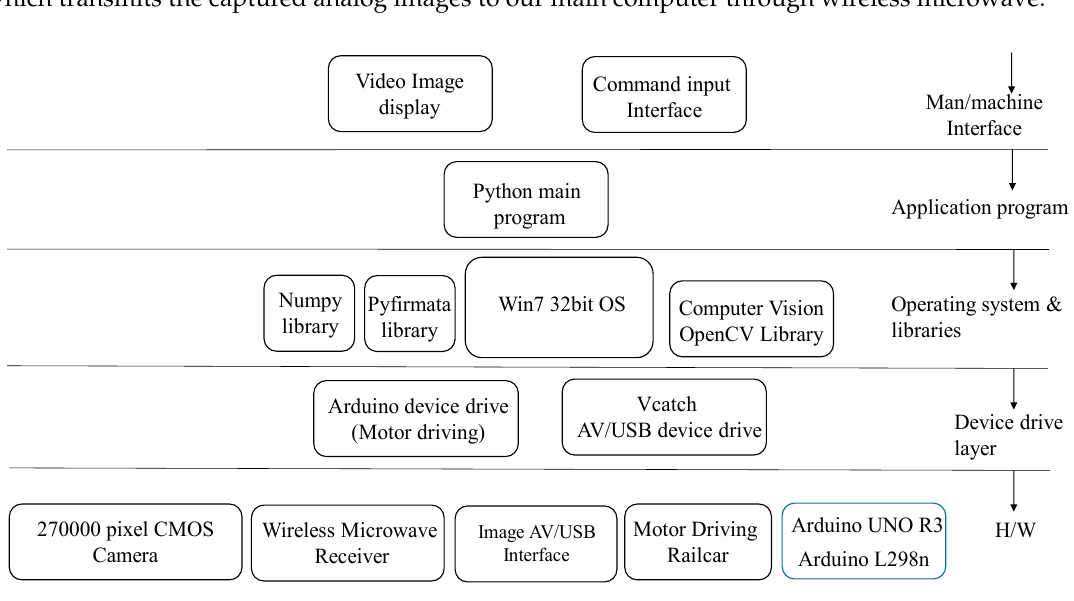
Figure 6. The experiment facility. 4. Experiment Results 4.1. Introduction to Testing Program After setting up our experiment facility, the test program was run to verify the proposed method. When the program starts to execute, the model railcar is given 55% of its power to run smoothly. At the same time, an input interface window, as shown in Figure 7, jumps out onto the screen. The input interface can take the commands of four different users, these being “a”, “d”, “s” and “t”, where “a” stands for accelerate, “d” for decelerate, “s” for stop and “t” for turn around.